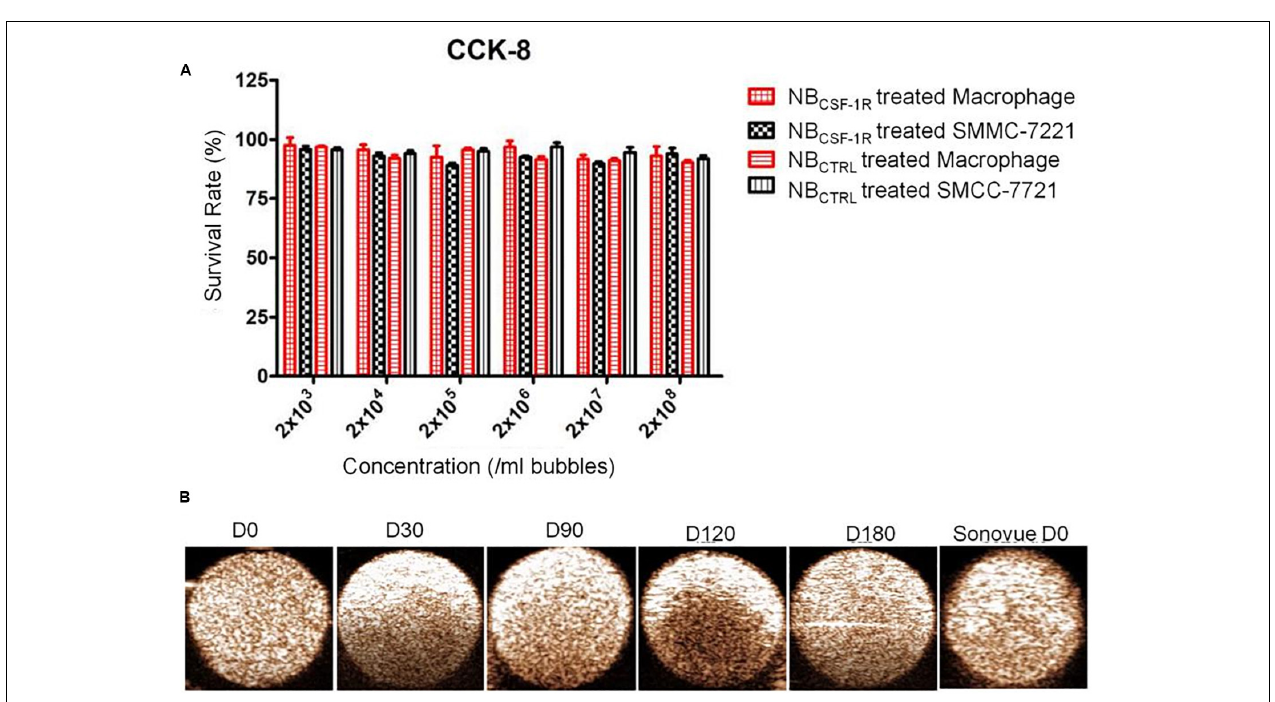
FIGURE 5 | (A) Cell viability test for NB CSF − 1R determined through CCK-8. In vitro cytotoxicity assays using macrophage and (high CSF-1 expression) and SMMC-7721 cells (low CSF-1 expression) incubated with NB CSF − 1R for 24 h; there was no significant difference in the viability of macrophages and SMMC-7721. (B) In vitro ultrasound images of NB CSF − 1R stored for 0, 30, 90, 120, 180 days, and the Sonovue R (cid:13) stored for 0 days as a control. Ultrasound frequency, 20 MHz.